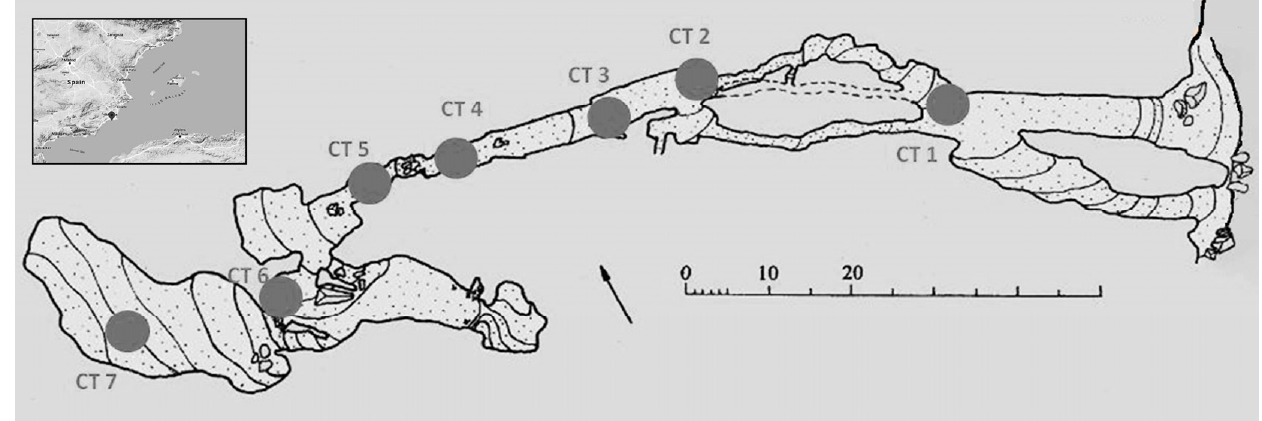
Figure 5. Location and sampling map of CT12 cave, Murcia region, Spain [114].